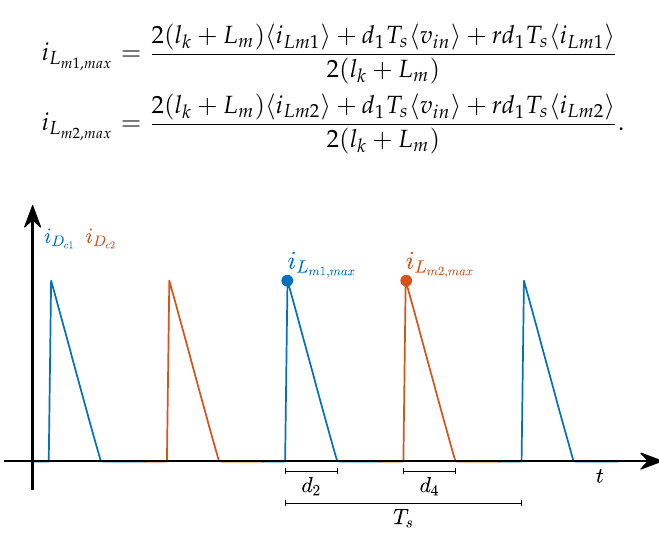
Figure 3. Clamp diodes’